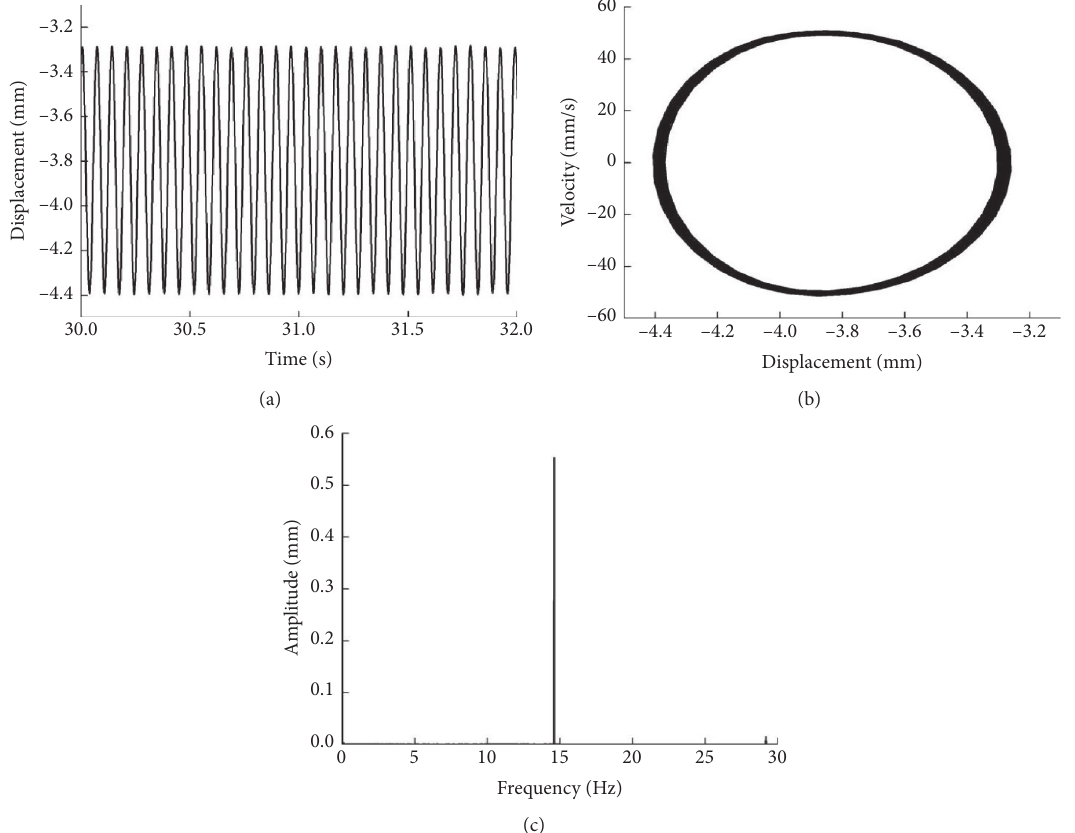
Figure 24: Period-1 motion of the system is obtained for the external excitation frequency Ω � 14 . 6 Hz: (a) waveform; (b) phase portrait; (c) amplitude